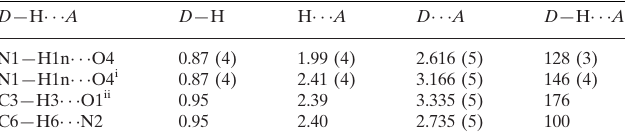
Hydrogen-bond geometry (A˚ , (cid:2)